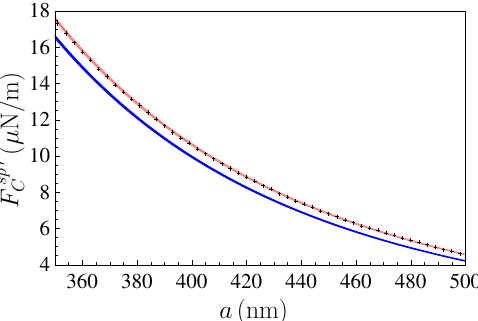
Figure 1. The mean measured gradients of the Casimir force between an Au-coated sphere and an Au-coated plate are shown by crosses as a function of separations. For clarity only each third experimental data point is plotted. The bottom and top lines demonstrate theoretical predictions of the Lifshitz theory obtained with inclusion and neglect of the relaxation of conduction electrons,